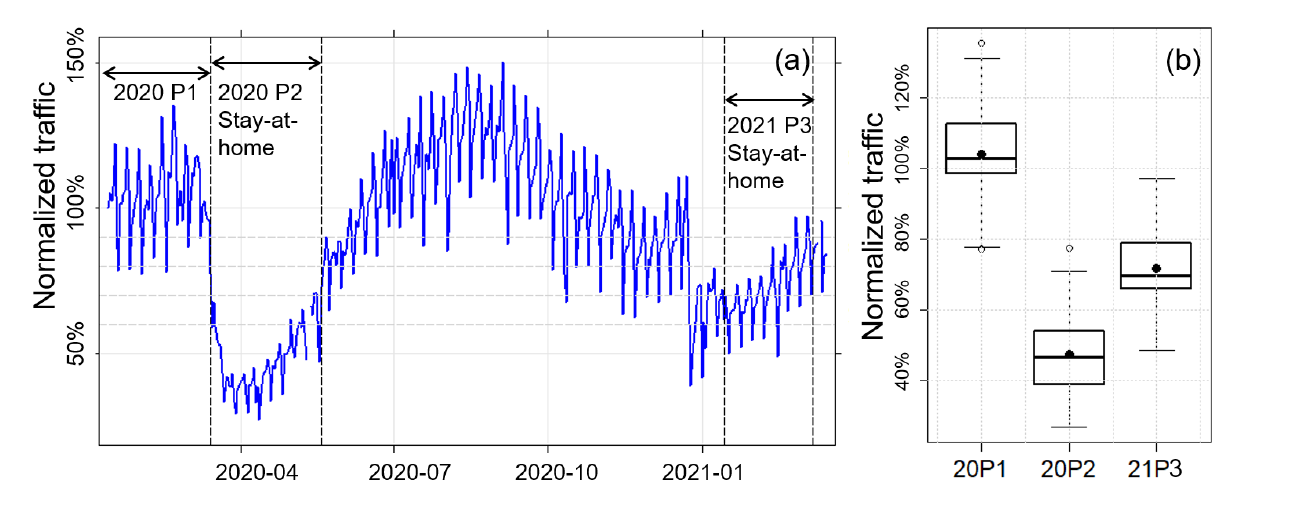
Figure 1. ( a ) Normalized daily traffic counts in greater Toronto area. Data are from Apple mobility data (https://covid19. apple.com/mobility, accessed on 29 June 2021). The reference traffic is on 13 January 2020; ( b ) Box and whisker plot for traffic data from panel ( a ) in three periods: Period 1 in 2020, Period 2 in 2020, and Period 3 in 2021. The line in the box denotes the median, the filled dot in the box denotes the mean, the lower and upper bounds of box show the 25th and 75th percentiles, and the whiskers show ± 1.5 × interquartile range (IQR) from the bounds of the box. Open circles are data beyond the